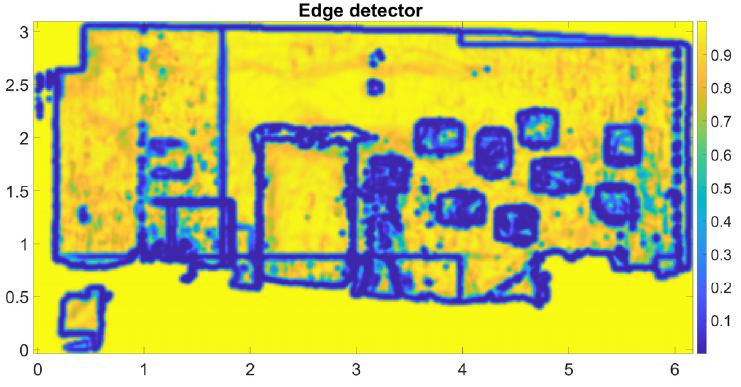
Figure 9. The edge detector function 𝐸(𝑥) .